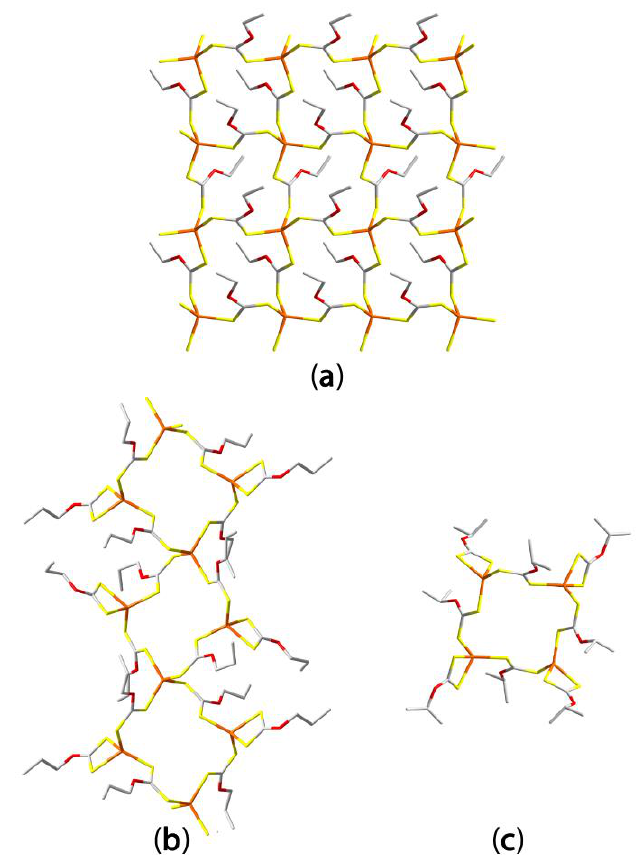
Figure 2. Aggregation in the crystals of ( a ) [Zn(S 2 COEt) 2 ] n ( 1 ); ( b ) [Zn(S 2 CO-n-Pr) 2 ] n ( 2 ); and ( c ) [Zn(S 2 CO-i-Pr) 2 ] 4 ( 3 ). Colour code in this and subsequent diagrams: zinc or cadmium or mercury, orange; sulphur, yellow; oxygen, red, carbon, grey. Non-acidic hydrogen atoms and solvent molecules have been omitted in all diagrams.